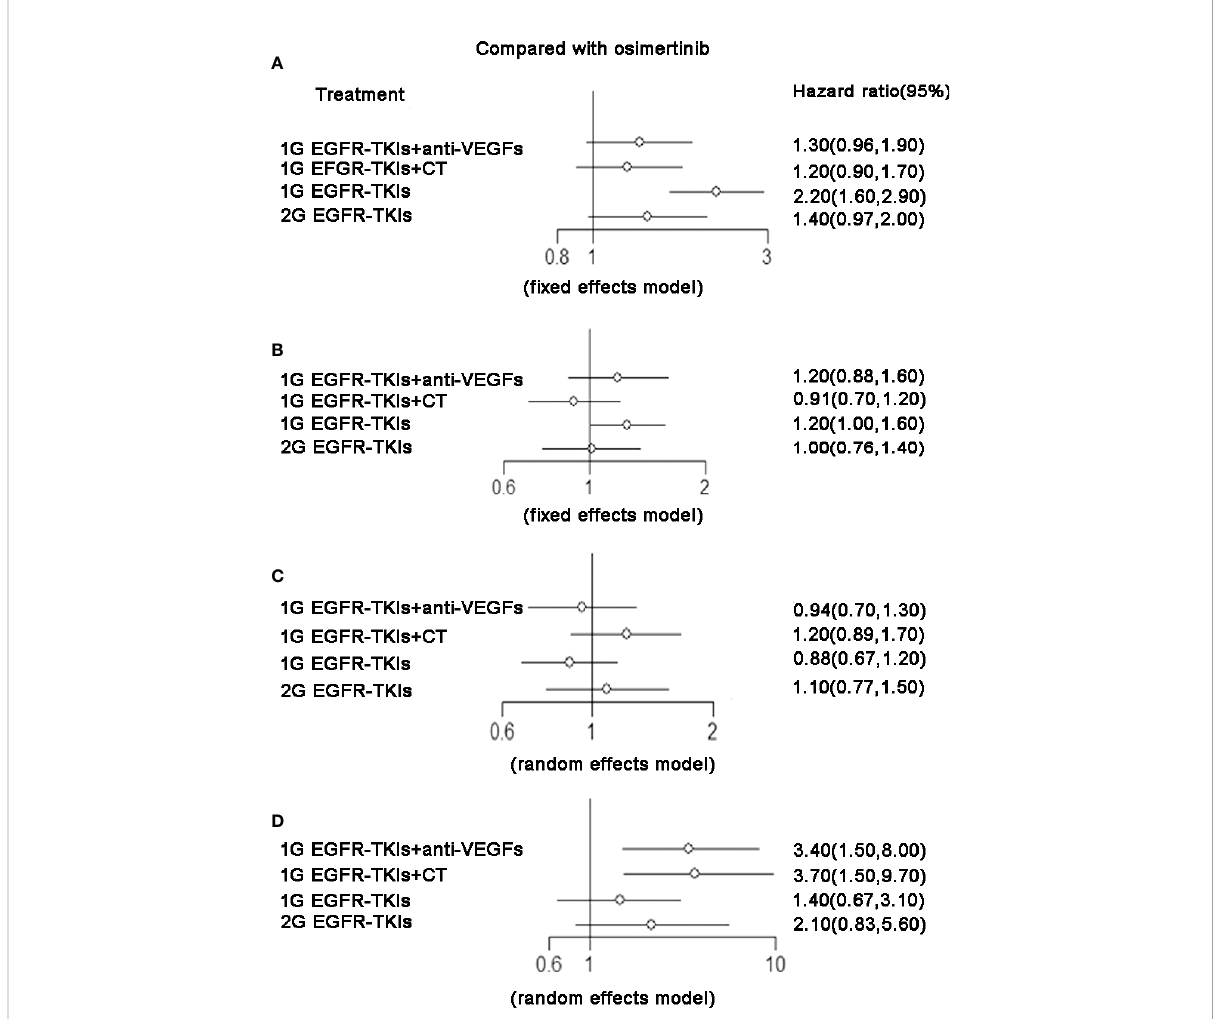
FIGURE 4 (A) Forest plot of hazard ratio (HRs) for progression-free survival (PFS) in patients with 19 deletion mutation; (B) Forest plot of hazard ratio (HRs) for progression-free survival (PFS) in patients with L858R mutation; (C) Forest plot of hazard ratio (HRs) for overall survival (OS) in patients with 19 deletion mutation; (D) Forest plot of hazard ratio (HRs) for overall survival (OS) in patients with L858R mutation. Results were based on fi xed effects or random effects methods. First-generation EGFR-TKIs (1G EGFR-TKIs); Second-generation EGFR-TKIs (2G EGFR-TKIs); anti-vascular endothelial growth factor drugs